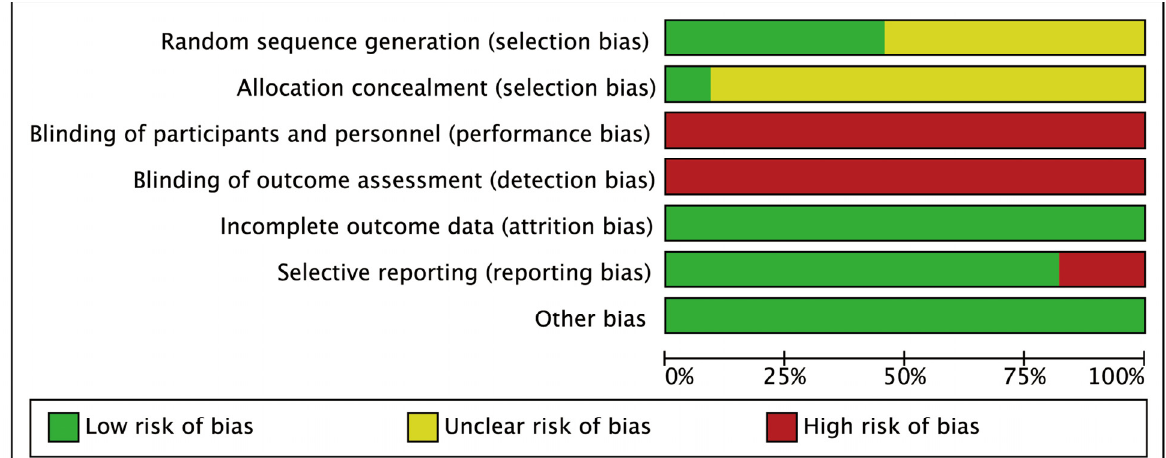
Figure 2. Diagram for the risk of bias.